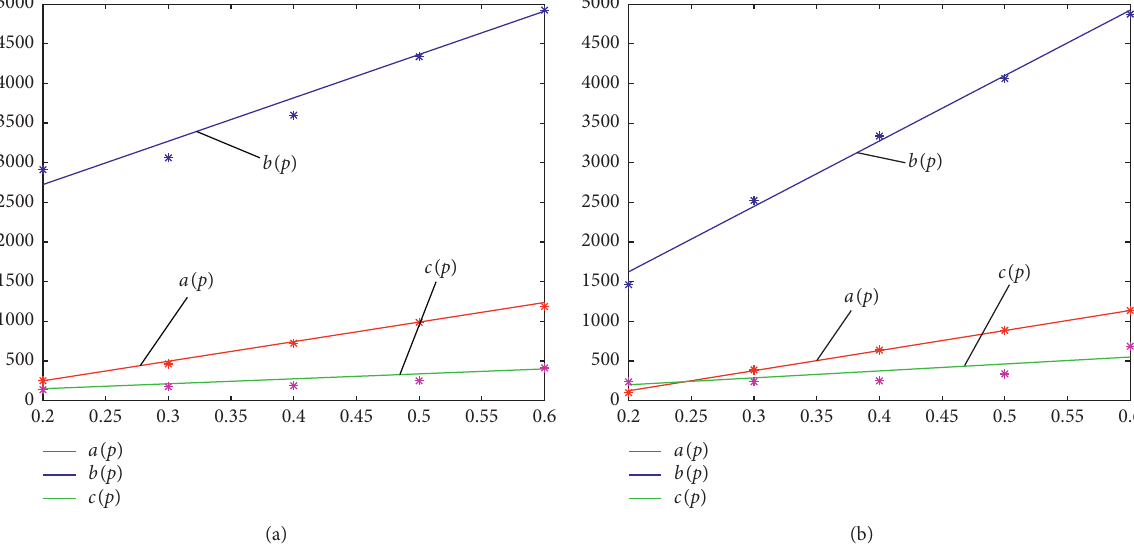
Figure 9: Fitting curve of a , b , and c on pressure p with the PAM shrinking (a) and stretching (b). Table 3: The fitting correlation coefficient of a , b , and c on pressure p with PAM shrinking and